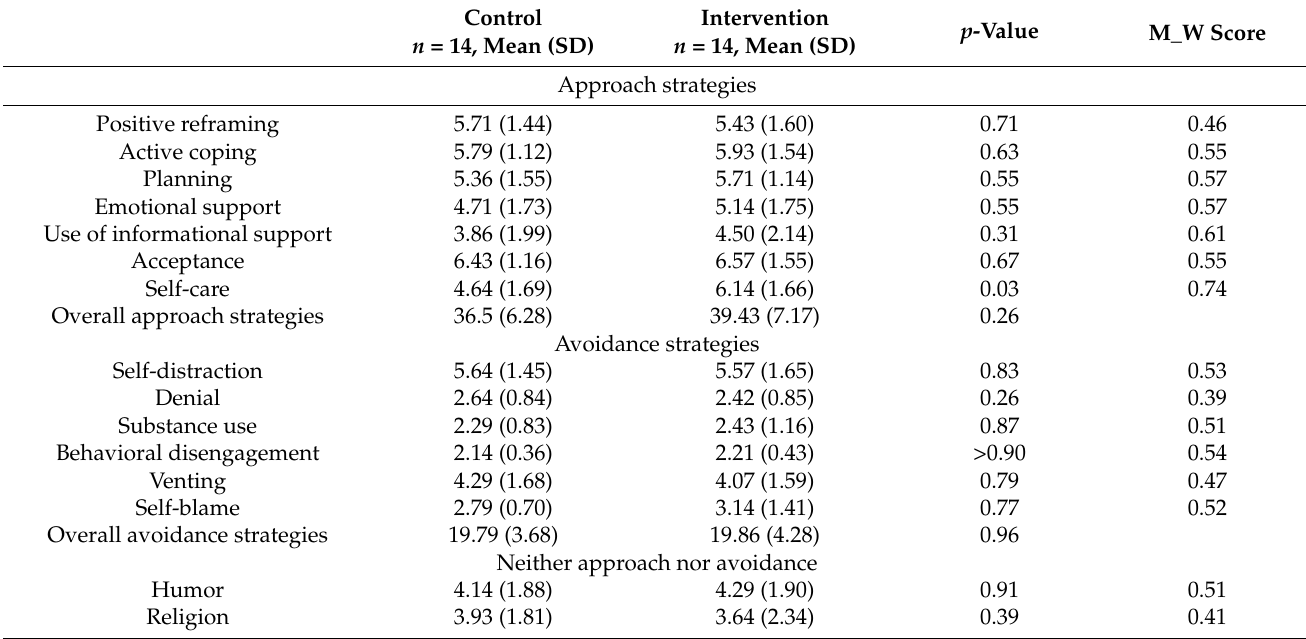
Table 2. Participant coping strategies during the COVID-19 pandemic. Control Intervention Approach strategies